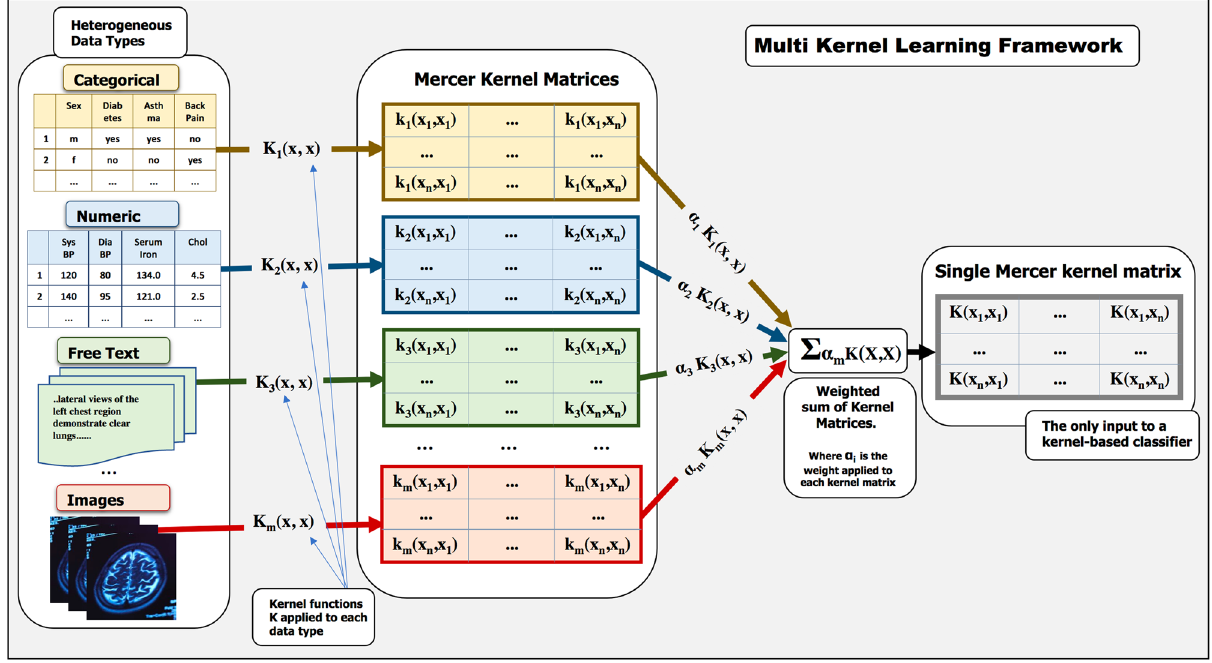
Figure 3. The multi kernel learning (MKL) framework for combining kernels derived from disparate data